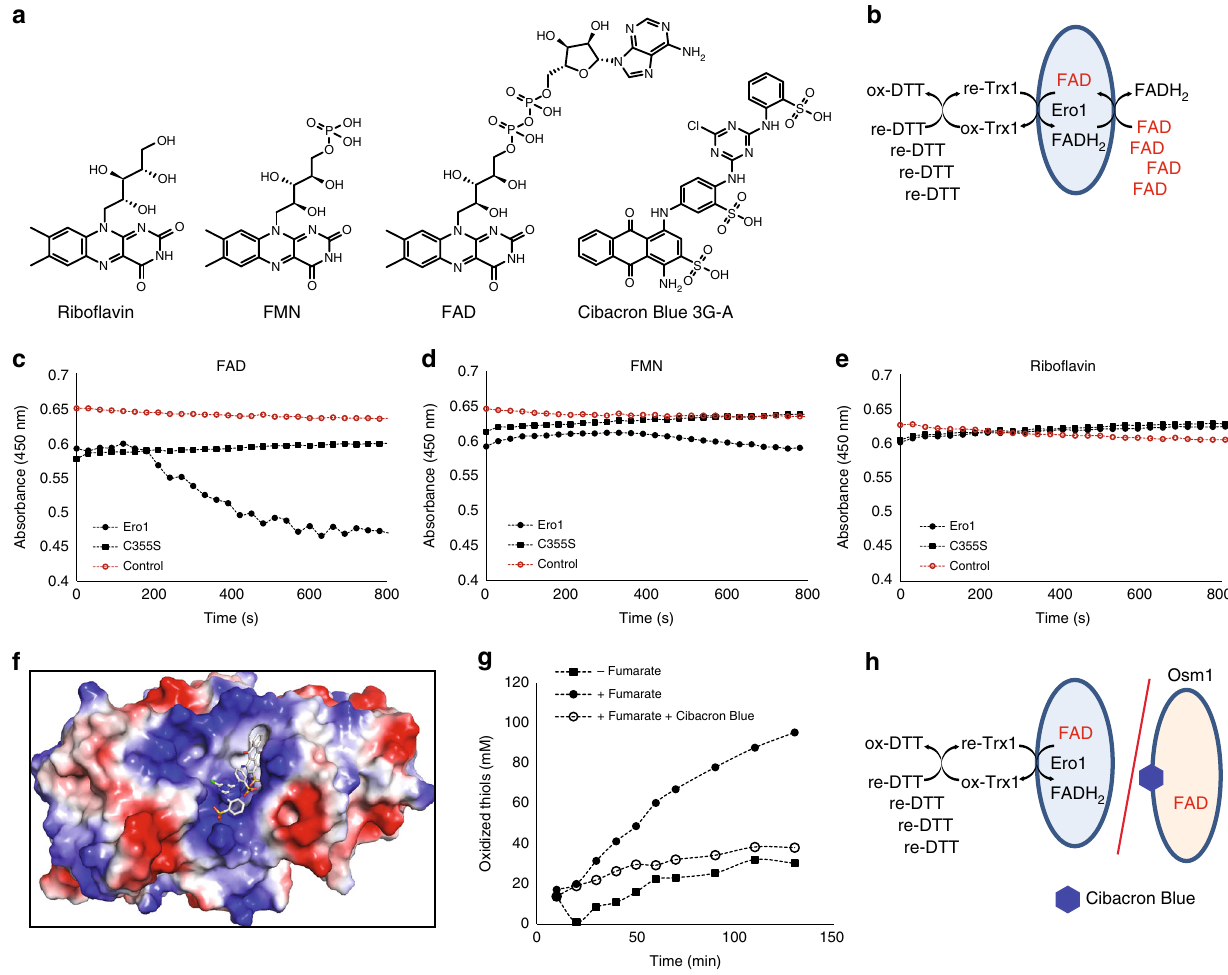
Fig. 5 Effect of blocking the second FAD-binding pocket. a Chemical structures of ribo fl avin, FMN, FAD, and Cibacron Blue 3G-A. b Model system used to assess the ability of Ero1 to transfer electrons to free FAD. c – e Ero1 can only transfer electrons to FAD. Under airtight conditions, Ero1, or Ero1-C355S, was activated by adding a reduced thiol mix (DTT and thioredoxin) along with FAD ( c ), FMN ( d ), and ribo fl avin ( e ). Reduction of the fl avin molecules was then monitored by changes in absorbance at 450 nm. f Docking simulation for Cibcron Blue 3G-A binding to Osm1. g Cibacron Blue 3G-A inhibits anaerobic thiol oxidation by the Ero1-Osm1 system. h Model system used to assess inhibition of disul fi de bond formation by the Ero1-Osm1